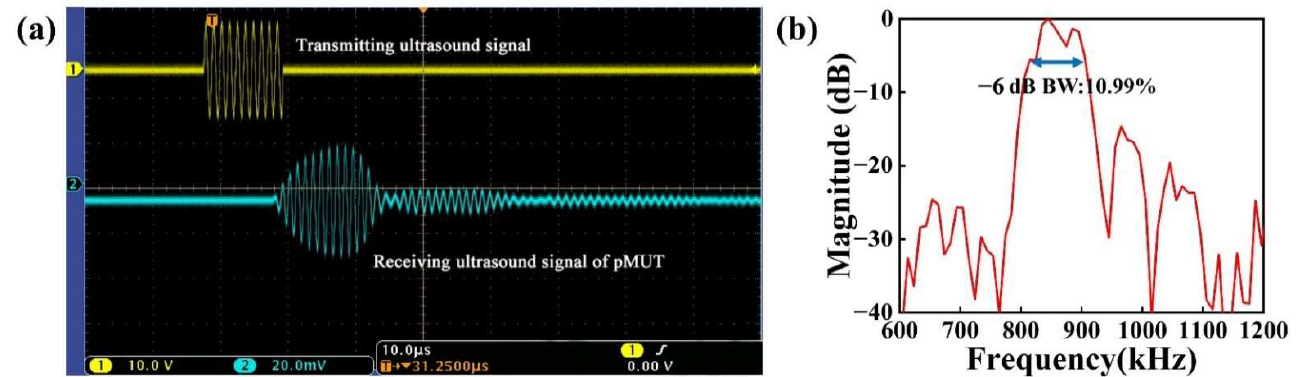
Figure 9. ( a ) Measurement results of receiving sensitivity of a pMUT with an I-shaped diaphragm; ( b ) the frequency response of a pMUT with I-shaped diaphragm.